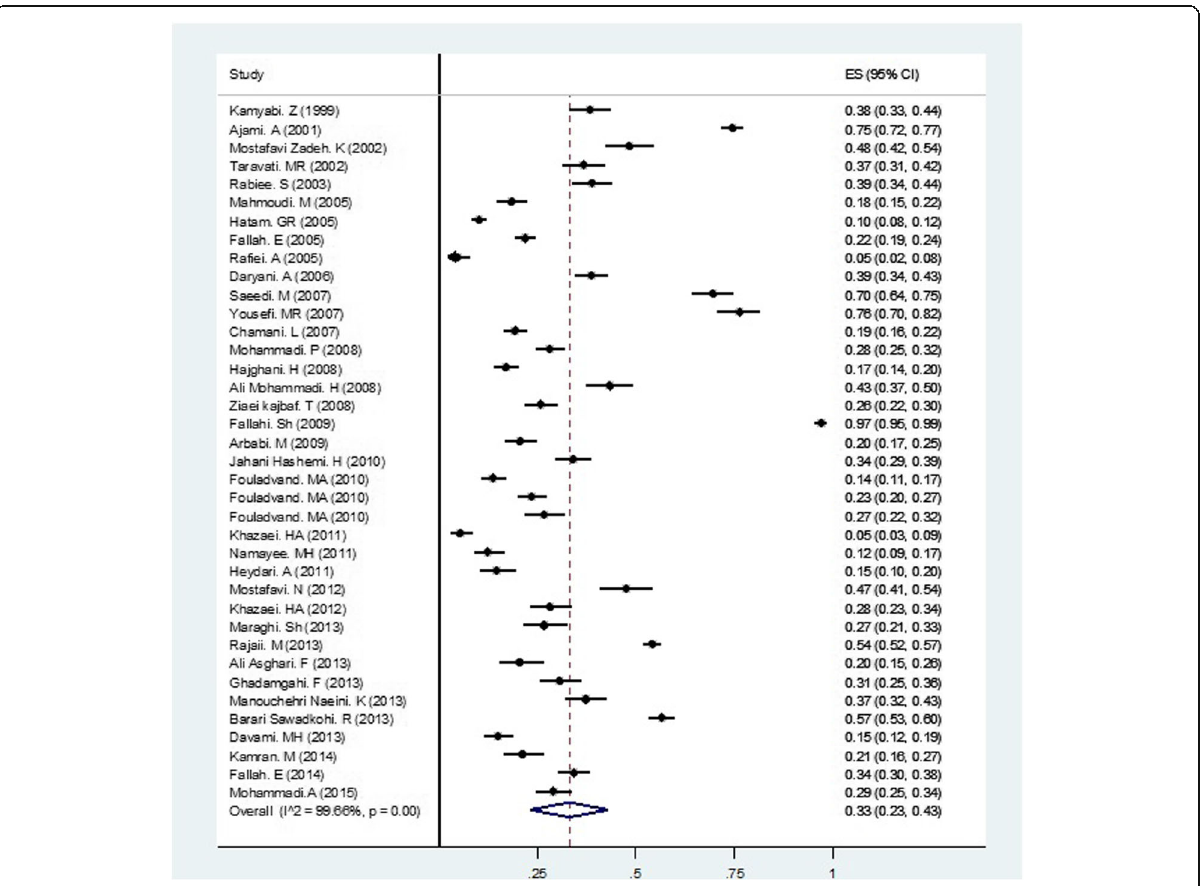
Fig. 2 Random-effect meta-analysis of pooled estimation of Toxoplasma gondii in girls and women of childbearing age